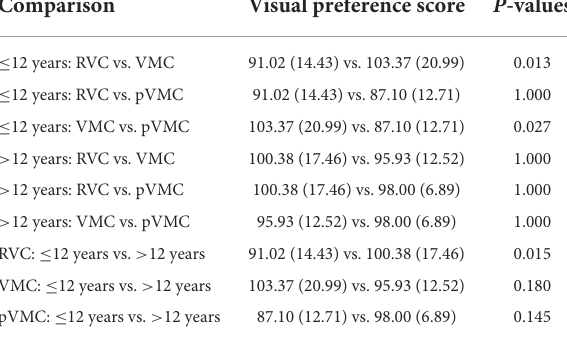
TABLE 4 Pairwise comparison of visual preference score.